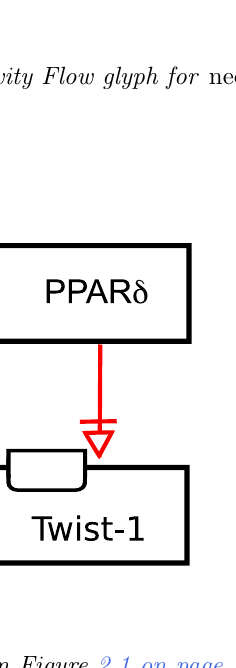
Figure 2.21: An example, taken from Figure 2.1 on page 4, of necessary stimulation where nuclear hormone receptor PPAR δ transcription factor activity is necessary for the stimu- lation of the Twist-1 gene